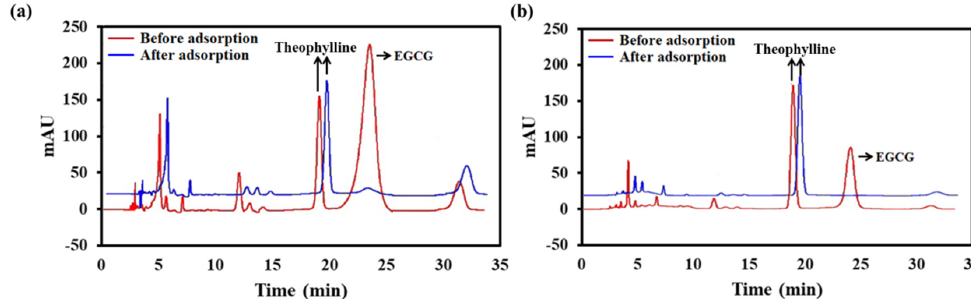
Figure 2. Confirmation of EGCG absorbed by PILs specifically. ( a ): Chromatograms of the TPs before (red line) and after (blue line) incubated with PILs, the theophylline was spiked as the internal reference. ( b ): Chromatograms of the green tea extracts before (red line) and after (blue line) incubated with PILs.